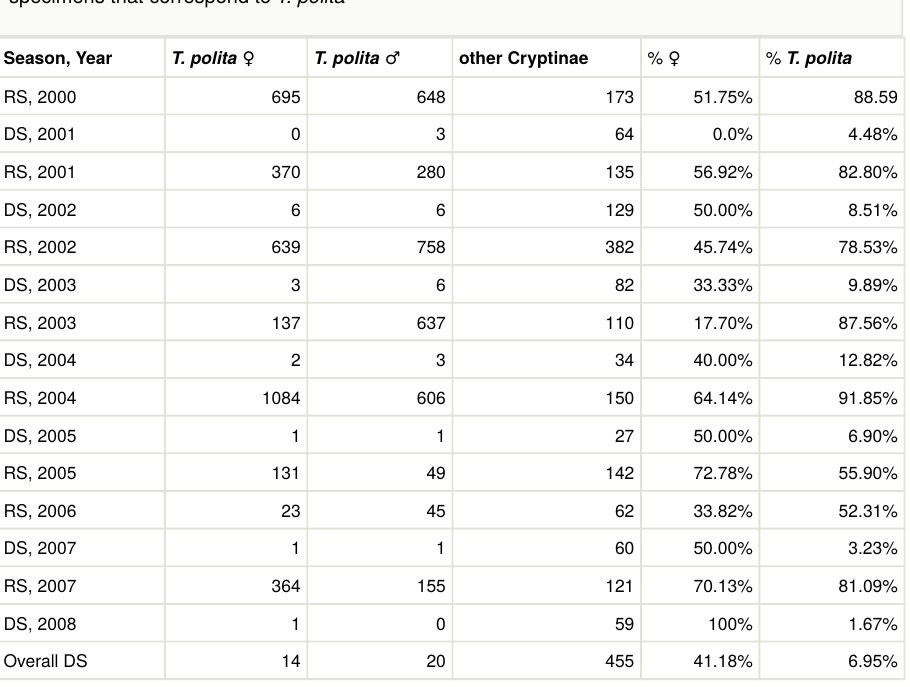
Number of females and males of T. polita collected, as opposed to all other Cryptinae combined. % ♀ , the percentage of specimens of T. polita that are females; % T. polita , the percentage of the total specimens that correspond to T.